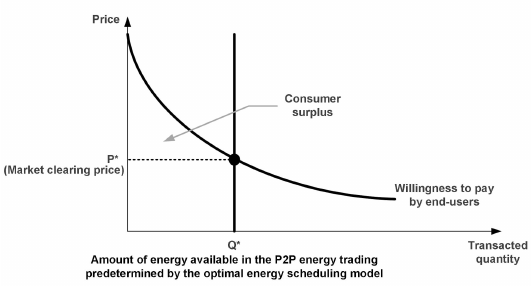
Figure 2. Determination of transaction price in an P2P energy trading